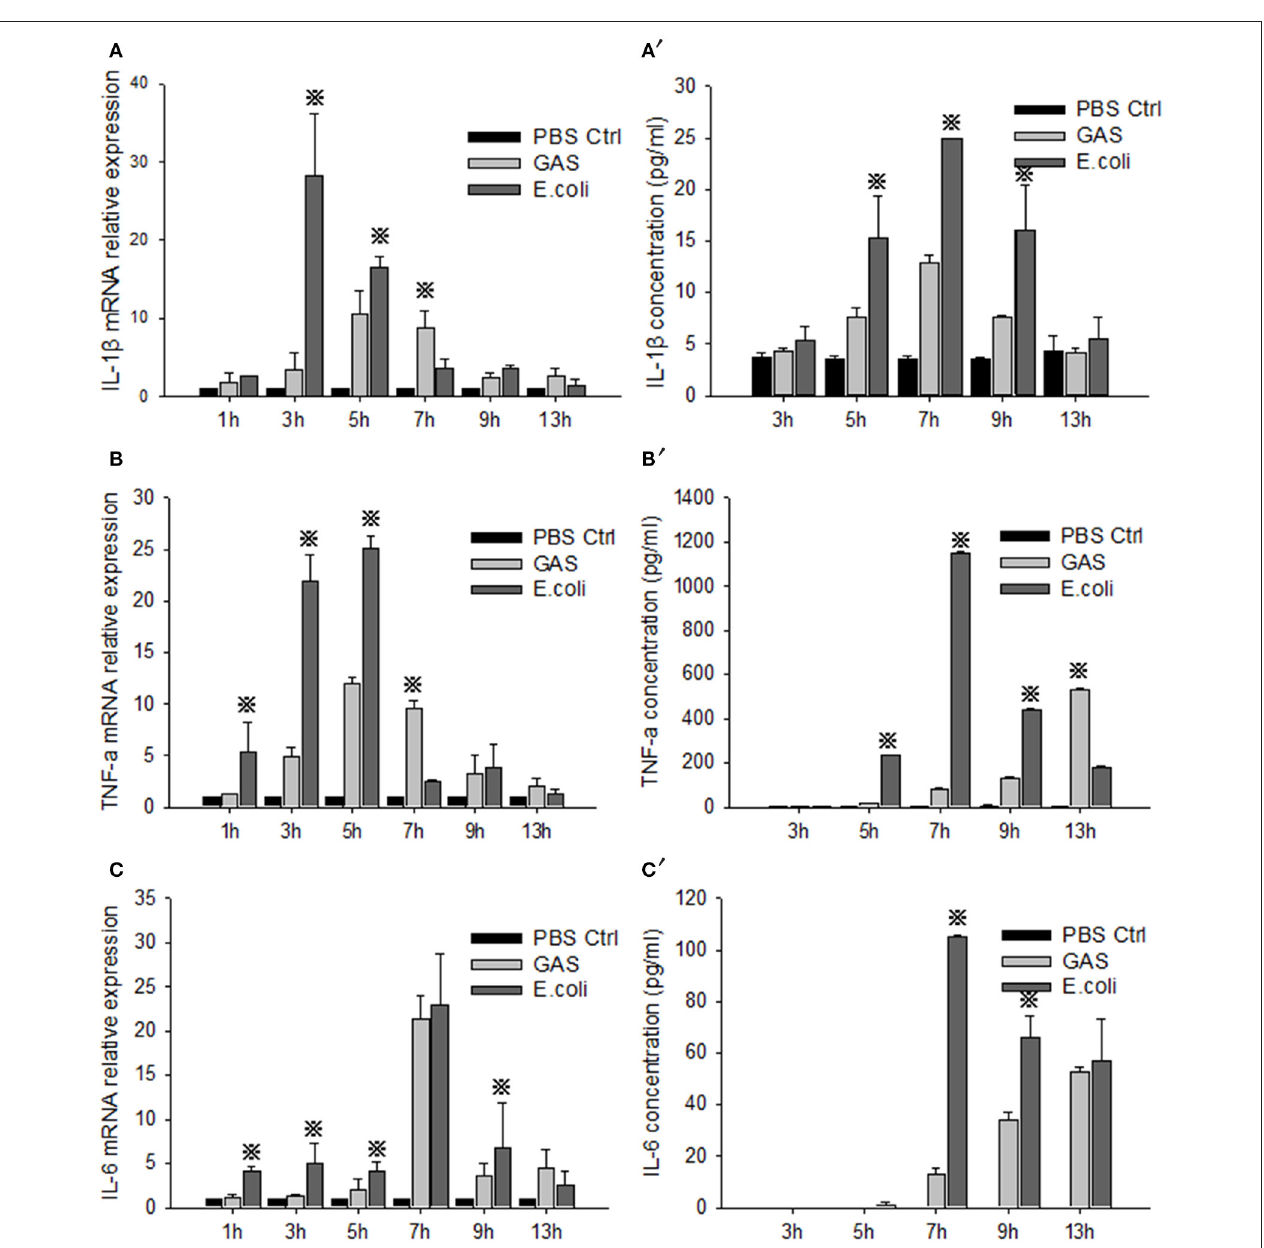
FIGURE 1 | Evaluation of proinflammatory cytokines in RAW cells stimulated with GAS or E. coli . RAW264.7 cells were seeded at a concentration of 1 × 10 6 /well in a 6-well plate containing medium without antibiotics overnight and then infected with GAS, or E. coli as a control, at an MOI of 10. We then collected supernatant and cells from each group at different time points. Total RNA was isolated from cells using RNeasy, and qPCR analysis was performed to detect the mRNA level of IL-1 β (A) , TNF- α (B) , and IL-6 (C) . Simultaneously, ELISA was performed to detect the protein expression of IL-1 β (A ′ ) , TNF- α (B ′ ) , and IL-6 (C ′ ) in the cell supernatant. Each experiment was performed at least three times. Results are presented as mean ± SD. P < 0.05 vs. E. coli group.